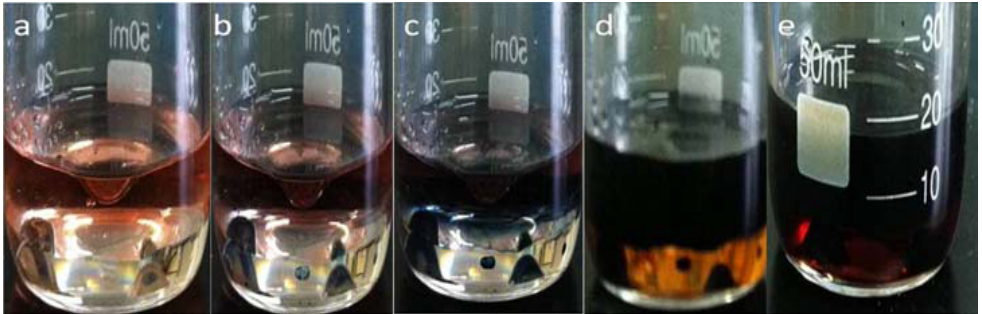
Figure 1. Interfacial polymerization of polyaniline (PANI) nanofiber at ( a ) 5s; ( b ) 20s; ( c ) 1min; ( d ) 5min; ( e )